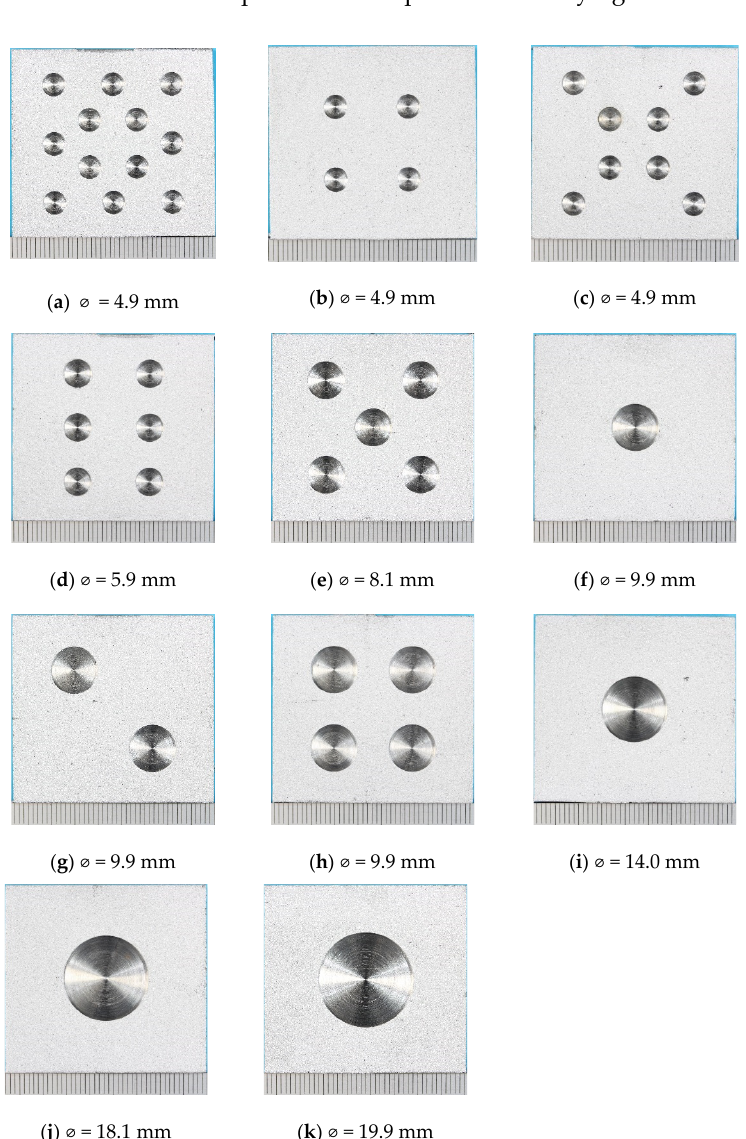
Figure 1. Photographs of specimens before testing showing holiday (damage) size and distribution. The number of holidays/total damage area % was: ( a ) 12/13.7%, ( b ) 4/4.6%, ( c ) 8/9.1%, ( d ) 6/9.9%, ( e ) 5/14.6%, ( f ) 1/4.6%, ( g ) 2/9.1%, ( h ) 4/18.3%, ( i ) 1/8.9%, ( j ) 1/14.8% and ( k ) 1/18.3%. Nominal diameter of each damage is also shown. The information is also provided in Table 3. Lacquer was applied to the back and sides of the specimens to define the test area and to stop unwanted galvanic corrosion of the TSA coating with the surfaces not TSA ‐ coated. A summary of the specimens used for testing is presented in Table 3. Table 3. Summary of the specimens used for testing along with the area of damage.